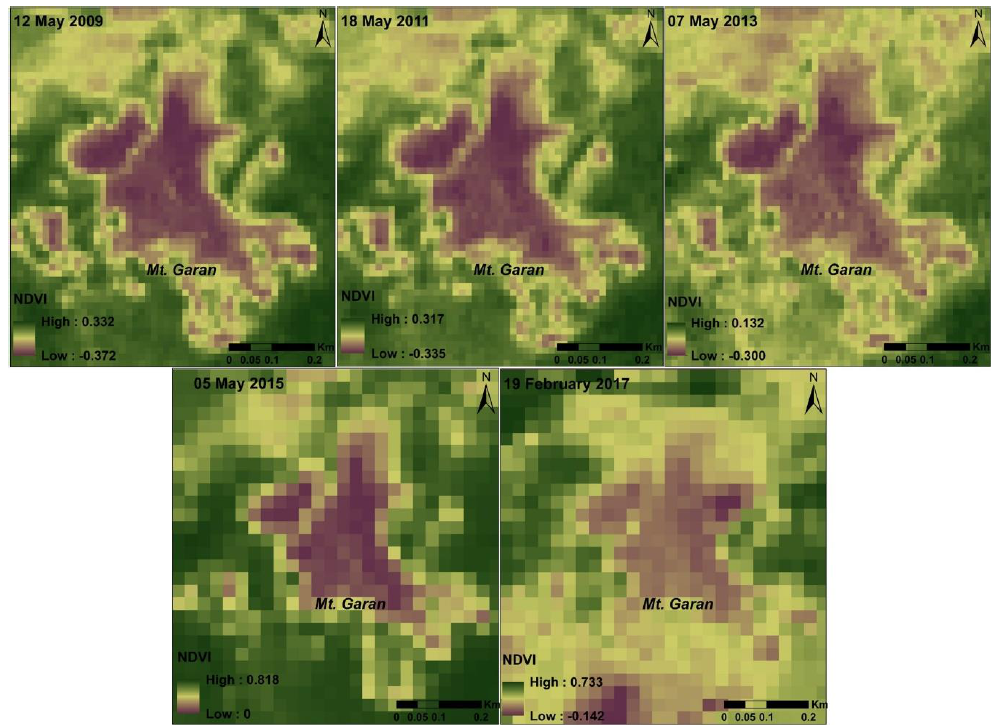
Figure 5. Normalized differential vegetation index (NDVI) of the Mt. Garan fumaroles area from 2009 to 2017. Higher NDVI values indicate healthy vegetation and lower values indicate bare land.